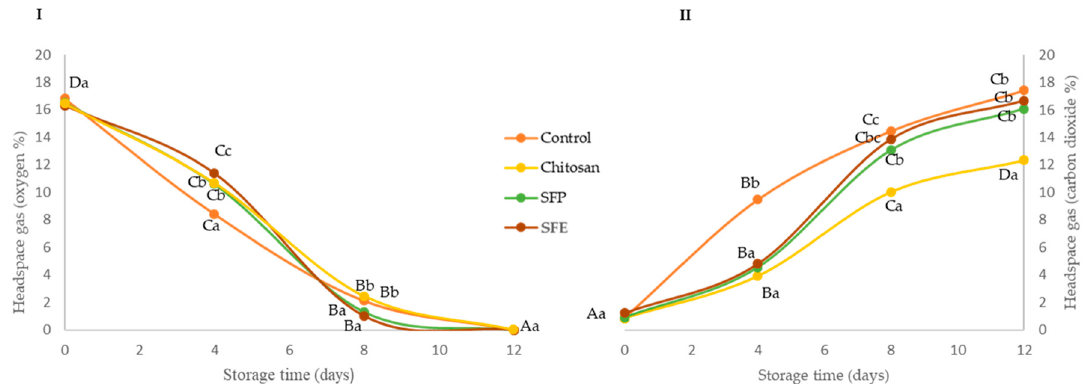
Figure 1. Oxygen ( I ) and carbon dioxide ( II ) headspace gas concentration (%) of Atlantic horse mackerel burgers coated with different film formulations (control without coating film, chitosan, sea fennel plant (SFP) incorporated in a chitosan-based film and sea fennel extract (SFE) incorporated in a chitosan-based film) and stored at 4 °C for 12 days. Different uppercase letters indicate significant differences ( p < 0.05) over storage time in each treatment. Different lowercase letters indicate significant differences ( p < 0.05) due to the treatment.